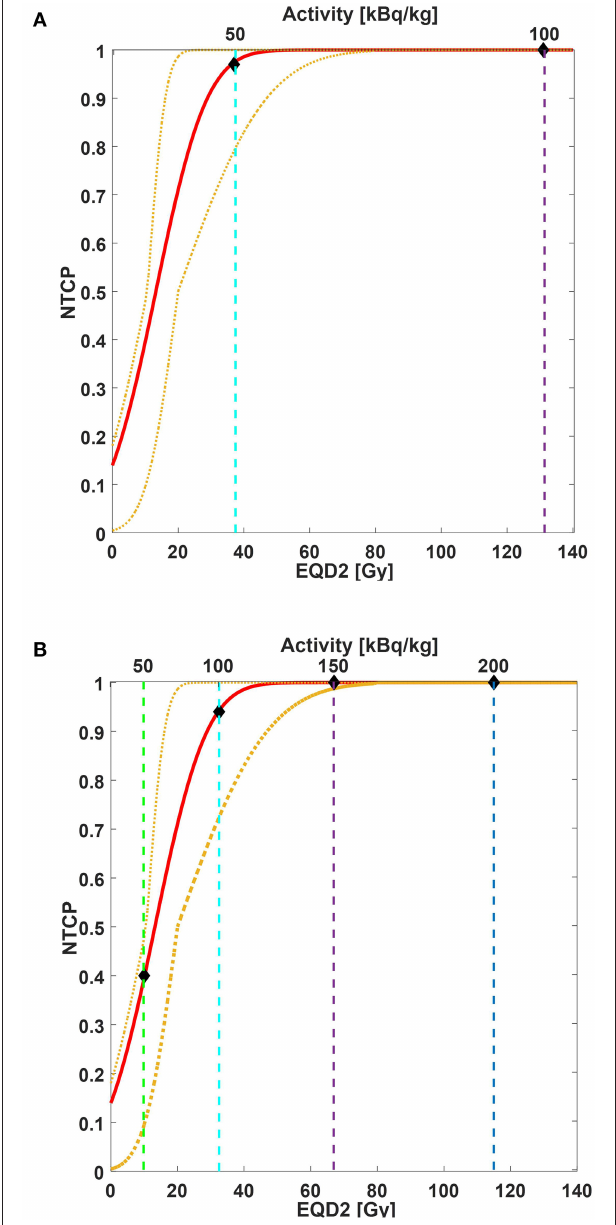
FIGURE 2 | NTCP curve (red line) of acute xerostomia incidence as a function of mean EQD2 values (bottom x-axis) and injected activity (top x-axis). Yellow dotted lines are 95% CI. NTCP model parameters: TD%50 14 Gy EQD2 , m = = 0.88. Considered endpoint: grade 2 xerostomia 3-month post-EBRT. ≥ Considered structures: salivary glands (parotid and submandibular glands together). Both EBRT and TAT doses were converted into EQD2. For EQD2 calculation: (A) predictive dose value estimated for our patient cohort and rescaled to Kratochwil et al.’s (8) mean predicted dose value is used; (B) predictive dose estimated for our patient cohort is used. Vertical dashed lines correspond to 50 kBq/kg (green line), 100 kBq/kg (cyan line), 150 kBq/kg (purple line), and 200 kBq/kg (blue line). Diamonds indicate the estimated incidence of acute xerostomia based on EBRT NTCP modeling for the injected activities of